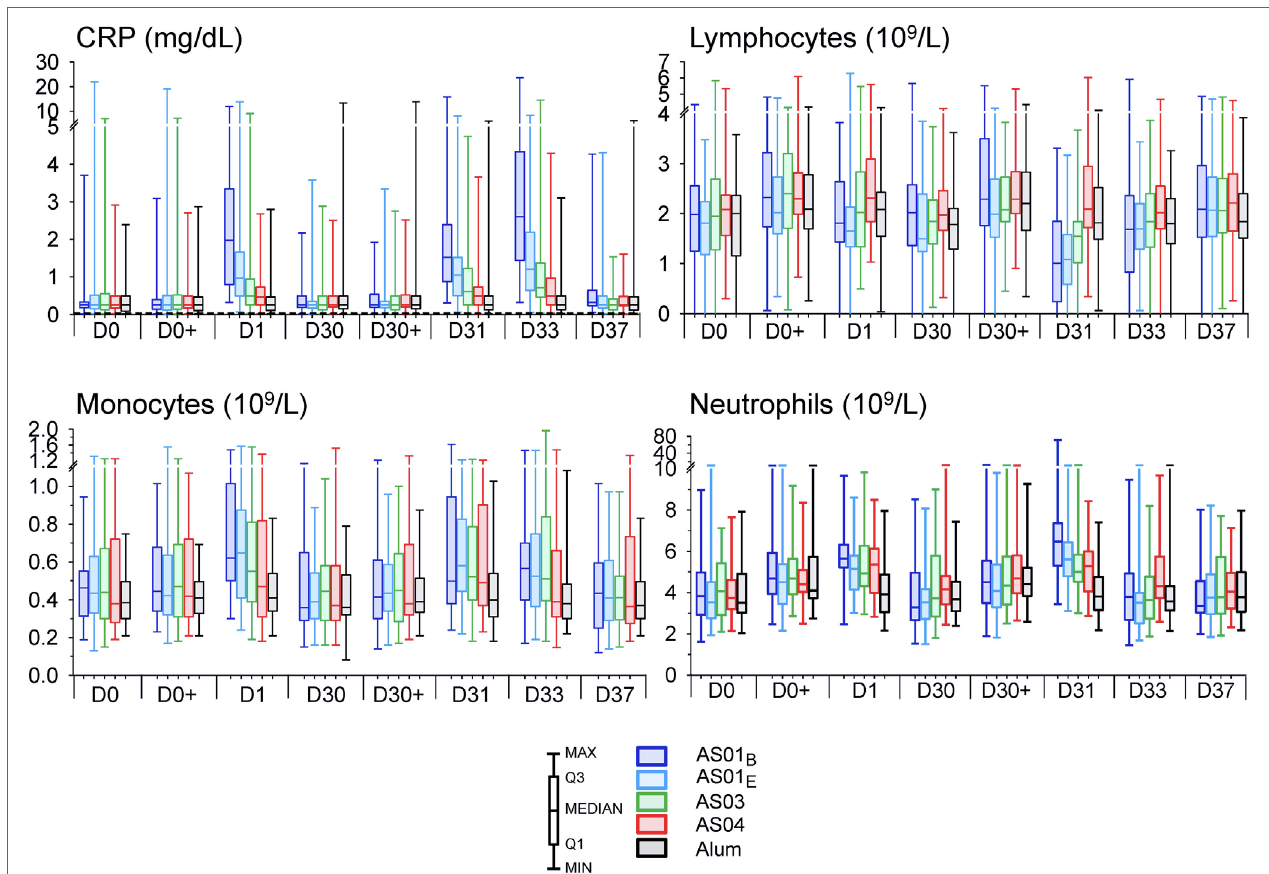
FiGUrE 2 | Innate hematology and C-reactive protein (CRP) responses. Normalized CRP concentrations ( N = 59, 57, 59, 61, and 55) and normalized lymphocyte, monocyte, and neutrophil counts ( N = 38, 40, 45, 39, and 41) in the AS01B, AS01E, AS03, AS04 and Alum groups, respectively, of the per-protocol cohort for innate immunogenicity are represented in box-whisker plots with medians, interquartile ranges, minima and maxima indicated. D,